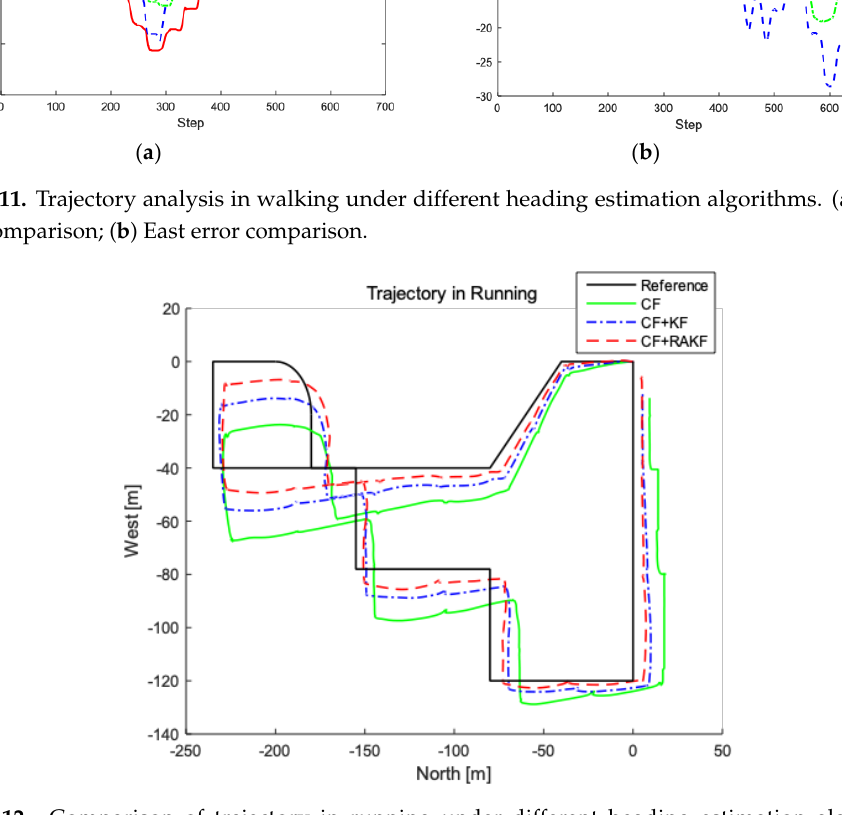
Sensors 2019 , 19 , x FOR PEER REVIEW 16 of 22 Table 2. Error comparison table in walking under different heading estimation algorithm. CF: complementary filtering; KF: Kalman filter.